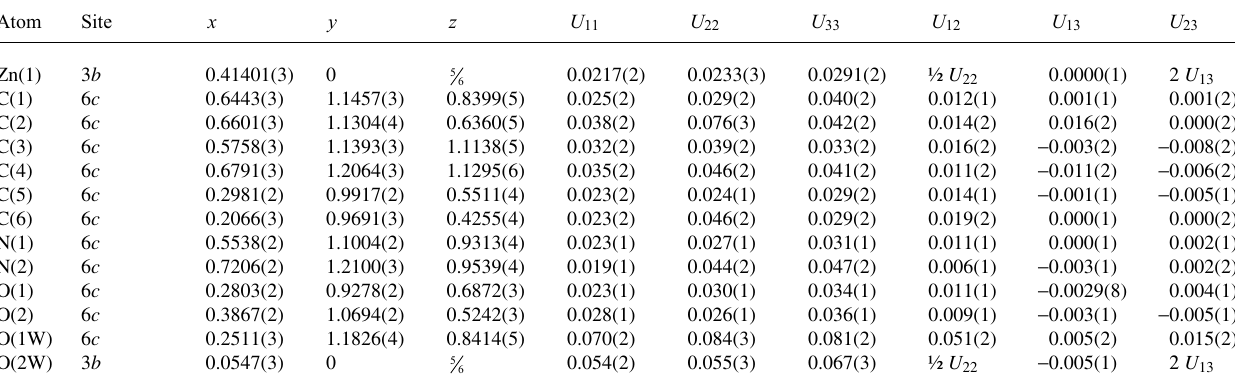
Table 3. Atomic coordinates and displacement parameters (in Å 2 )